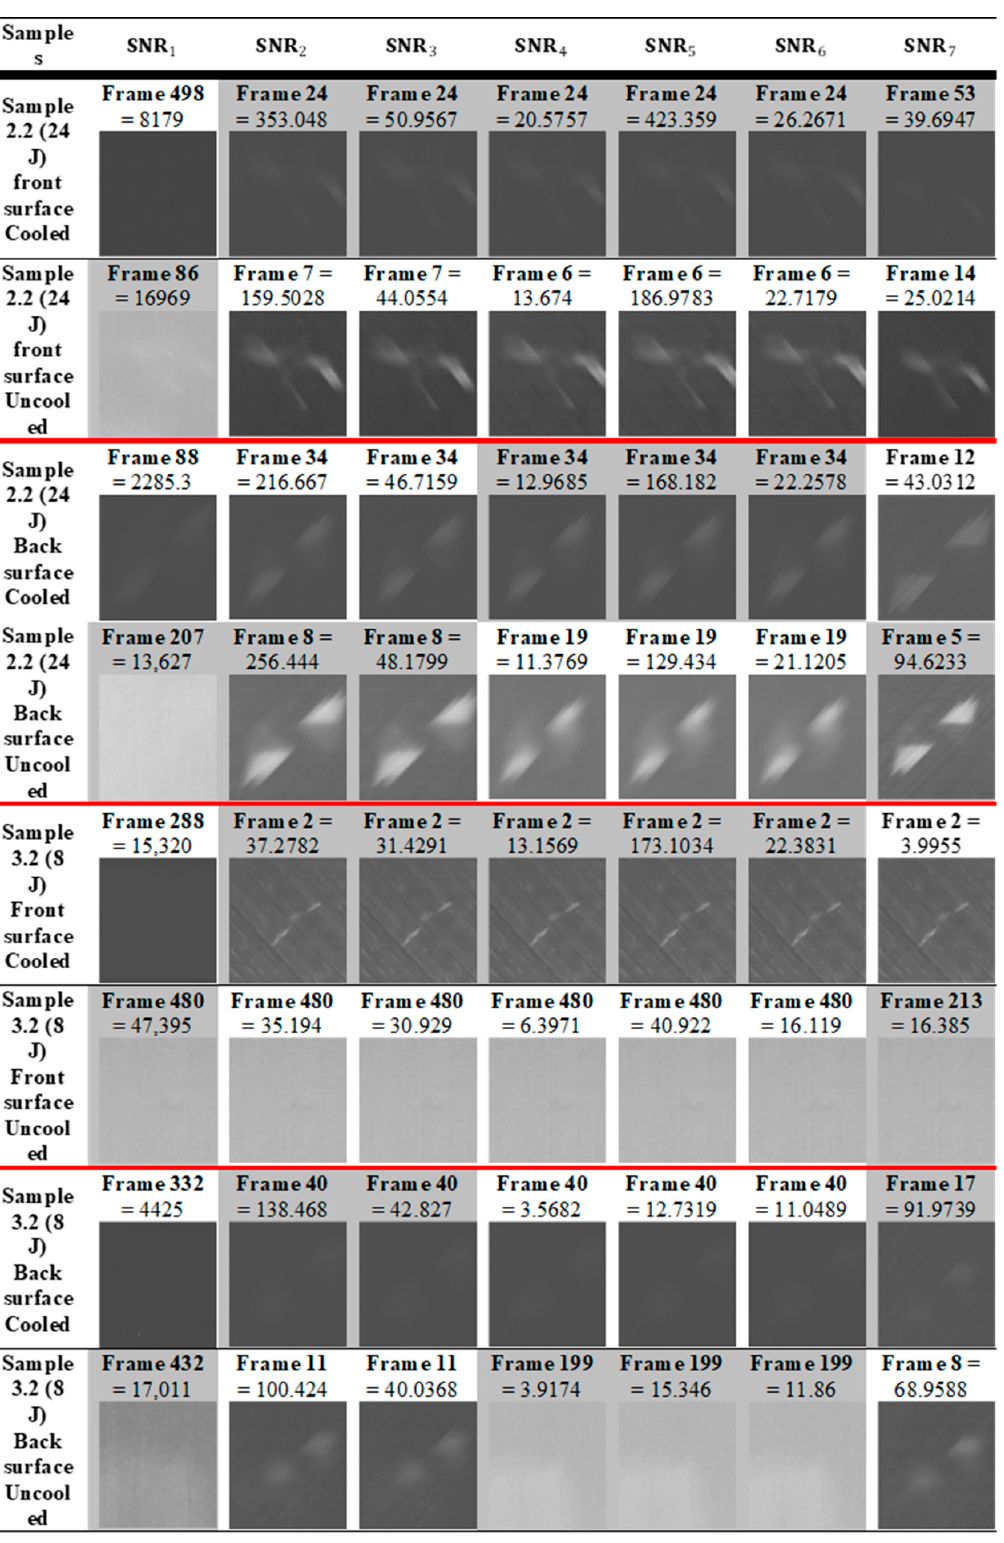
Figure 15. SNR equations 1–7 of the raw dataset from both the cooled and the uncooled IR camera. The numerical values are output after the SNR calculations from the pixel intensity regions selected within the defect and sound areas. The shaded boxes display the higher SNR value from the sample of the cooled and uncooled dataset.